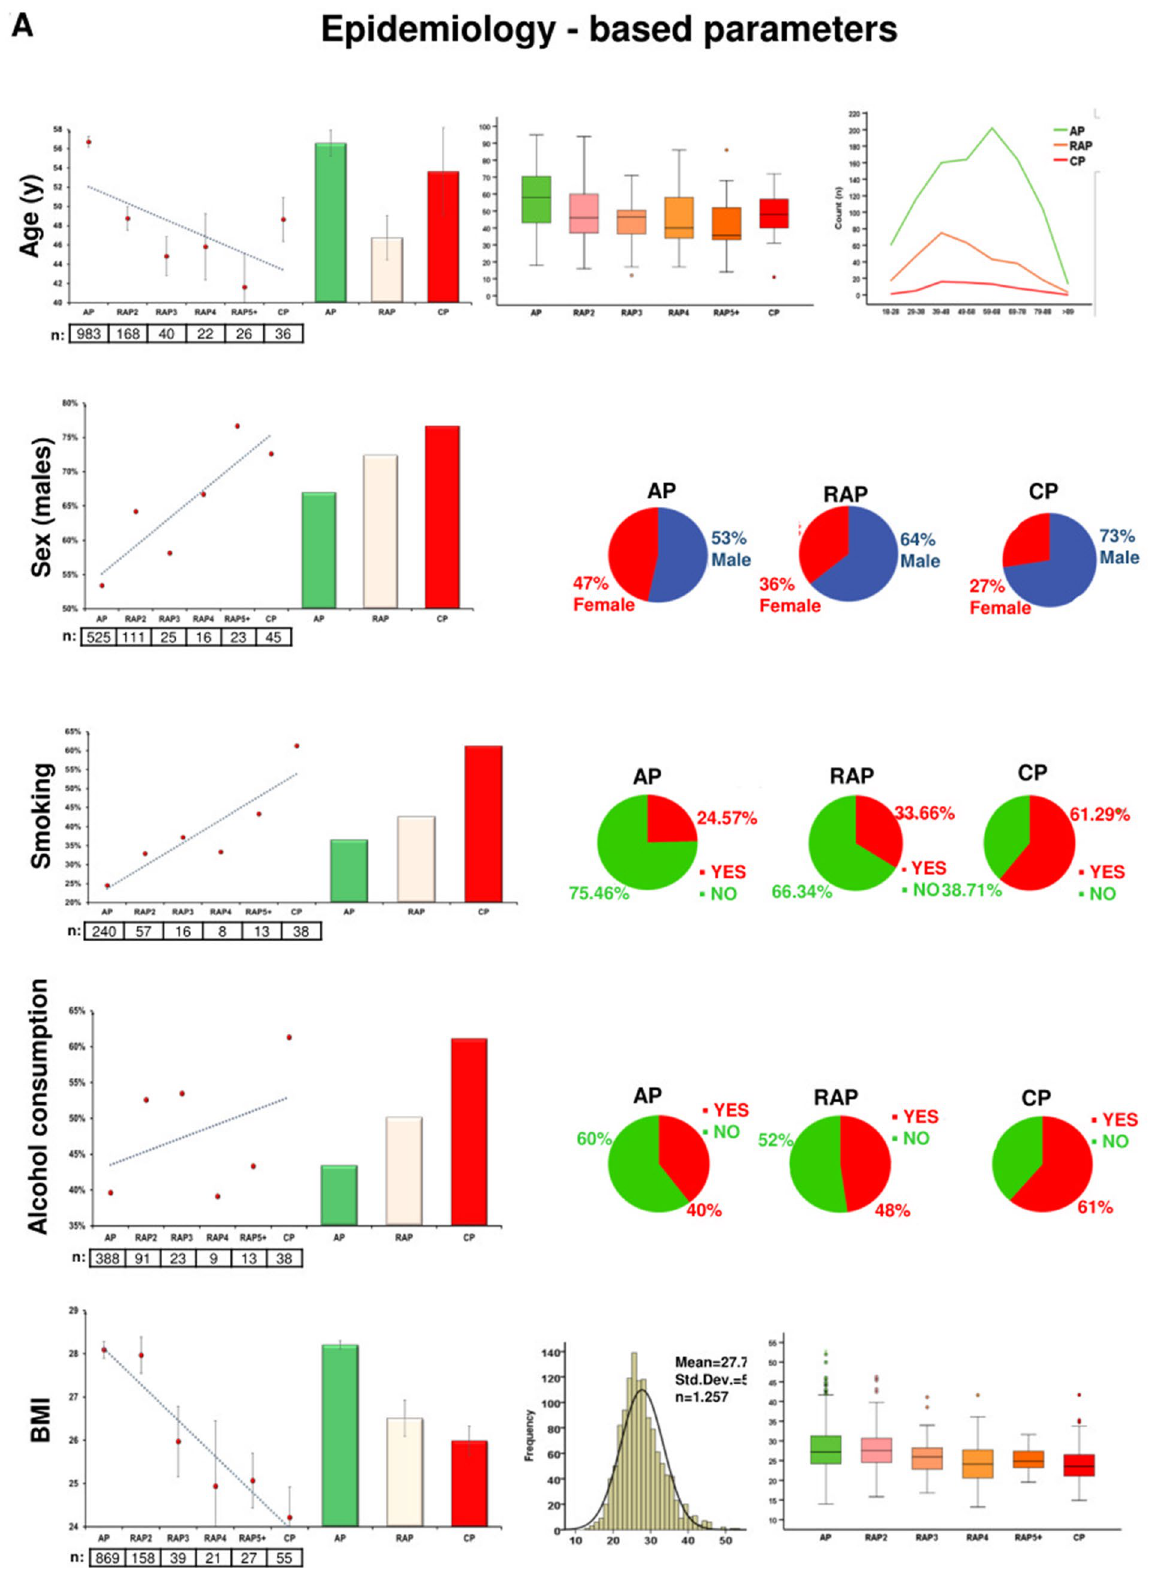
Figure 3. Descriptive and comparative statistics characterising fifteen biomarkers. ( A ) Epidemiology-based parameters: age, sex, smoking, alcoholic etiology and body mass index (BMI). ( B ) Etiology-based parameters: biliary or alcoholic etiology, bilirubin, gamma-glutamyl transferase (GGT), aspartate aminotransferase (AST) and alanine aminotransferase (ALT). ( C ) Laboratory-based parameter: red blood cell count (RBC). ( D ) Pancreas-dependent parameters: pseudocysts, amylase and lipase. ( E ) Differences in acute pancreatitis (AP) vs recurrent acute pancreatitis (RAP) 5 + and chronic pancreatitis (CP) comparisons in amylase and